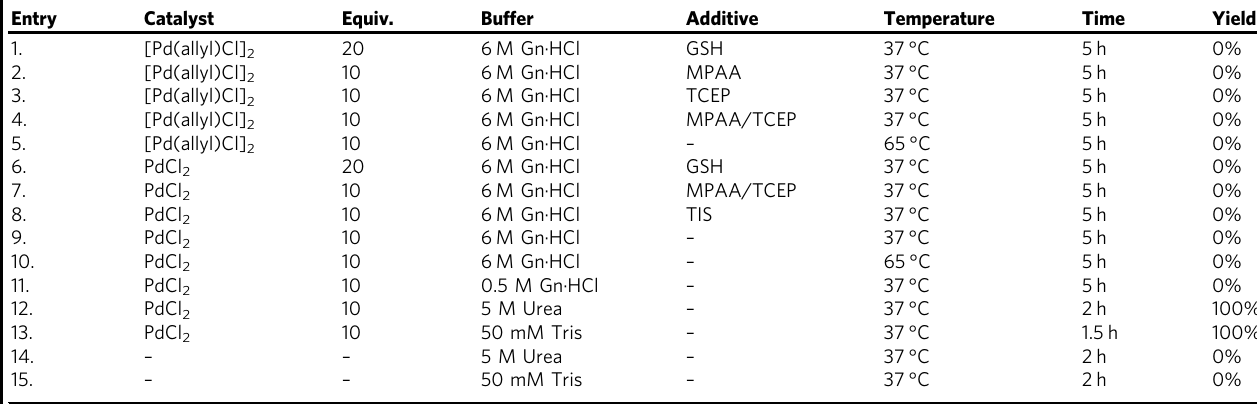
Table 1 Examining t -butyl deprotection under various